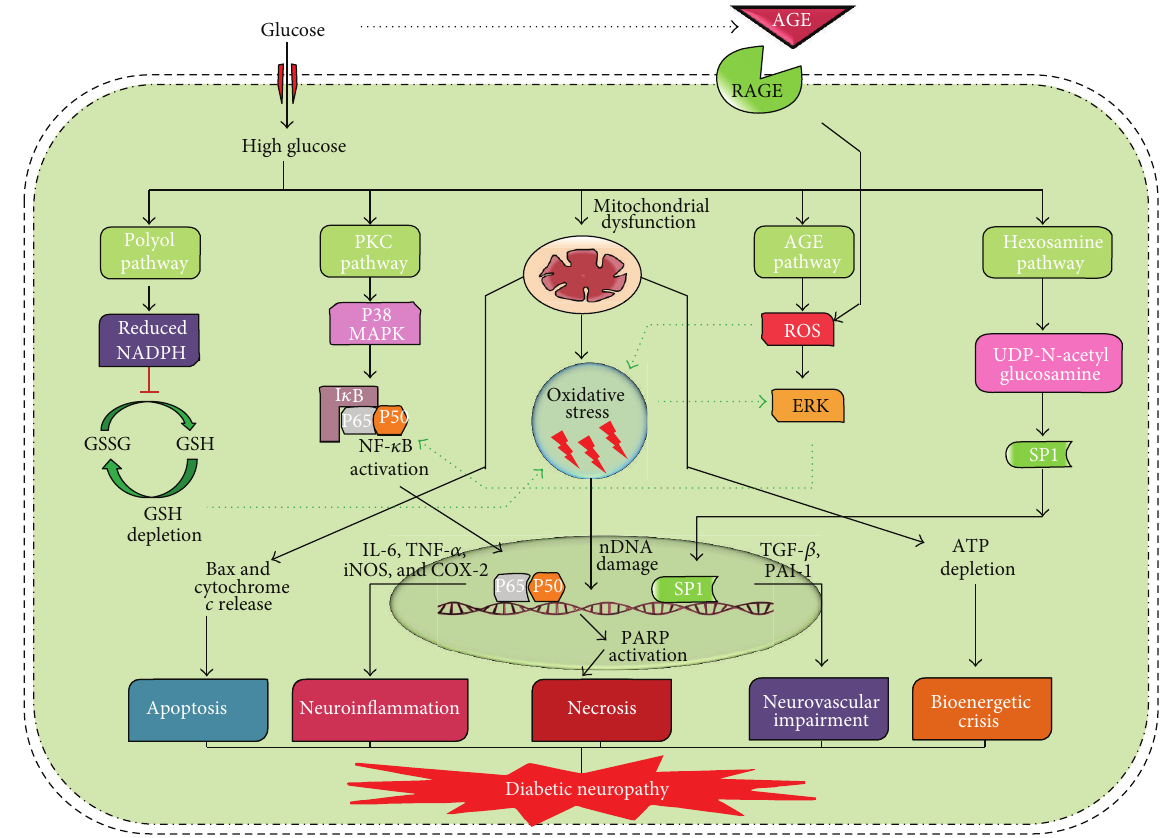
Figure 1: Pathophysiology of diabetic neuropathy. Hyperglycemia activates numerous metabolic pathways like polyol pathway, protein kinase c (PKC) pathway, advanced glycation end products (AGE) pathway, and hexosamine pathway. All these pathways are known to integrate through hyperglycemia mediated mitochondrial ROS production. Oxidative stress and these classical pathways in combination activate transcription factors such as nuclear factor kappa enhancer of B cells (NF- 𝜅 B) and speciality protein-1 (SP-1), resulting in neuroinflammation and vascular impairment. Further, these pathways combined with dysfunctional mitochondria mediated apoptosis or bioenergetic depletion can lead to neuronal damage lading to DN. Poly-ADP ribose polymerase (PARP) mediated NADH/ATP depletion can lead to neuronal dysfunction due to failure of various energy dependent processes in neurons. (ERK: extracellular related kinase, IL-6: interleukin-6, iNOS: inducible nitric oxide synthase, COX-2: cyclooxygenase-2, TGF- 𝛽 : transforming growth factor- 𝛽 , and PAI-1: plasminogen activator inhibitor-